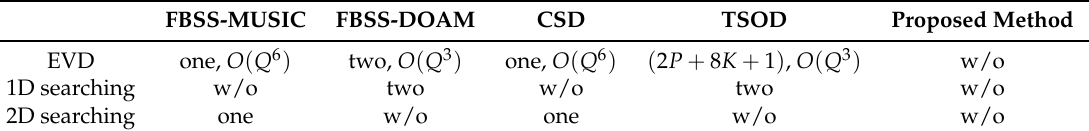
Table 1. Computational complexity